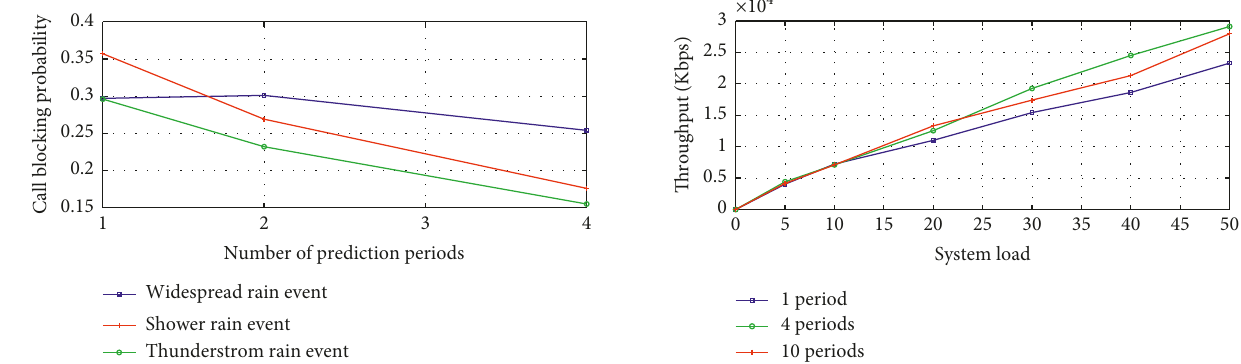
Figure 10: Throughput (thunderstorm rain